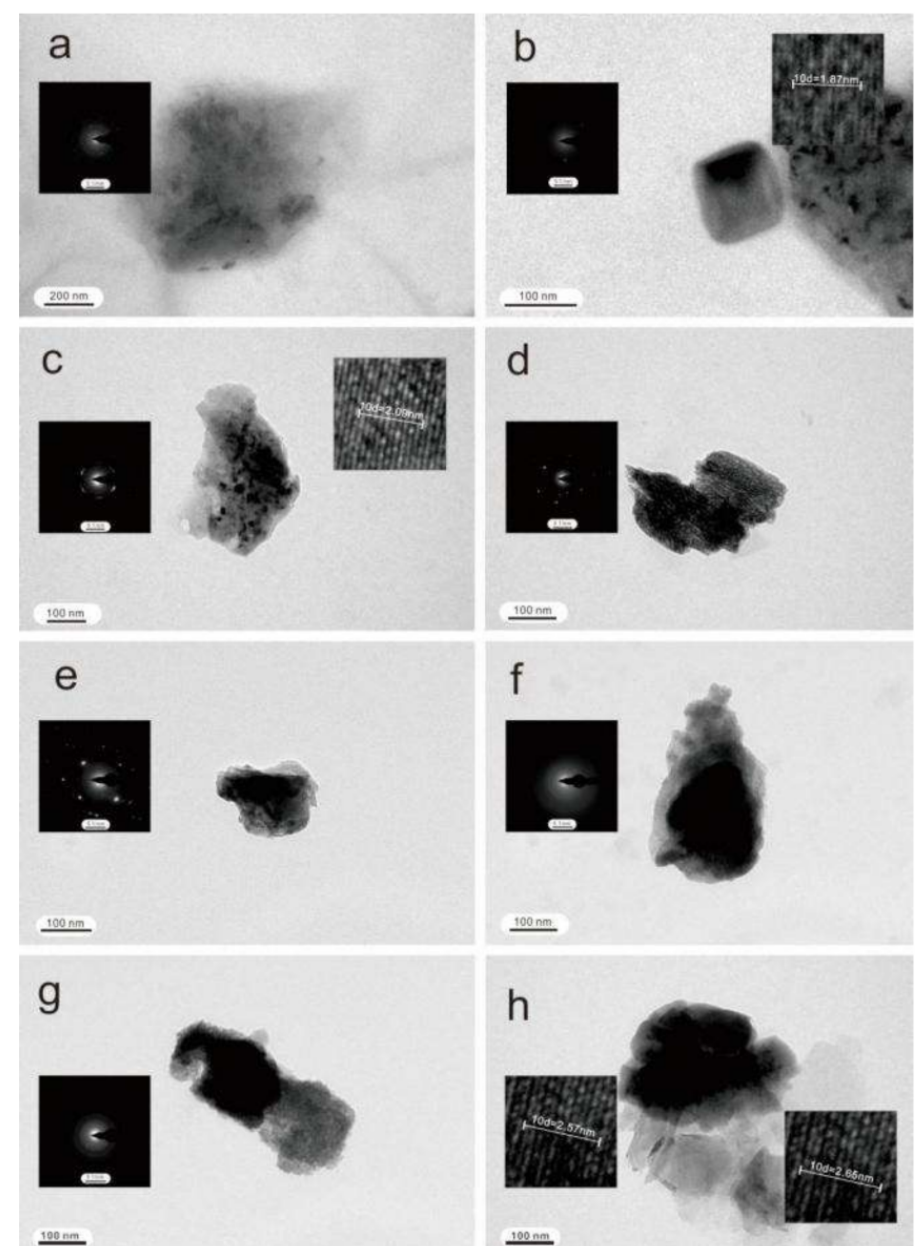
Figure 9. TEM photomicrograph of particles or aggregations in the well water ( a – d ) and in the deep groundwater ( e – h ). ( a ) TEM image and SAED pattern of an Fe-, Zn- and As-bearing aggregation (ID20). ( b ) TEM image, SAED pattern and HRTEM image of a Cu- and Sn-bearing particle (ID21). ( c ) TEM image, SAED pattern and HRTEM image of an Fe-, Cr-, Mn-, Cu-, Mo-bearing aggregation (ID21). ( d ) TEM image and SAED pattern of an Fe- and Co-bearing particle (ID23). ( e ) TEM image and SAED pattern of a V, Fe, Co and Zn-bearing particle (ID24). ( f ) TEM image and SAED pattern image of a Cu-, Mo- and Zn-bearing particle (ID25). ( g ) TEM image and SAED pattern of a Cu-, Sn- and Fe-bearing particle (ID26). ( h ) TEM image and HRTEM images of an Fe- and Pb-bearing aggregation